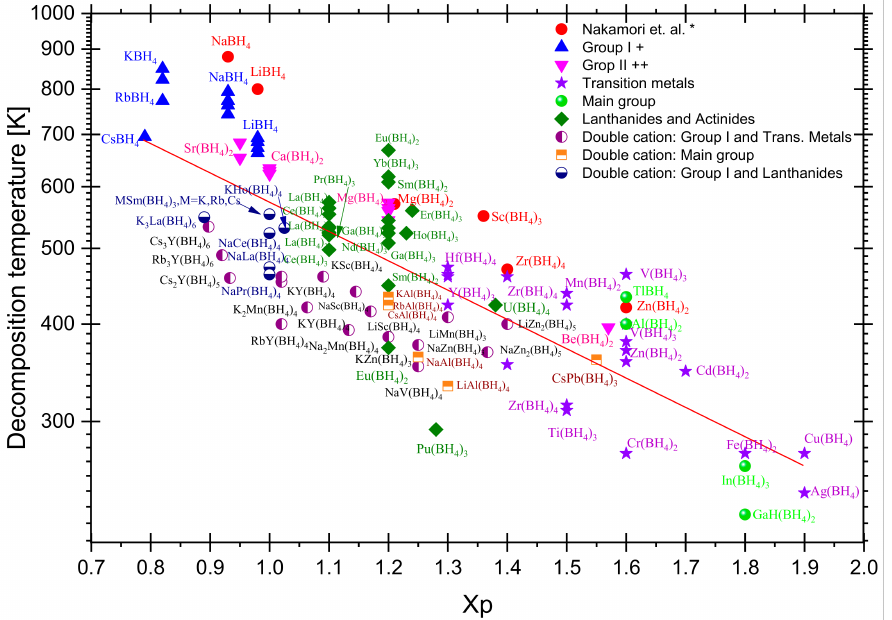
Figure 9. Compilation of dehydrogenation temperature (peak temperature whenever available, otherwise, onset temperature) versus Pauling electronegativity or weighted average Pauling elec- tronegativity. Source data: * (red dots) Nakamori et al. (2006) [30]. + Group I borohydrides: LiBH 4 [236–240], NaBH 4 [241–246], KBH 4 [4,247–249], RbBH 4 , and CsBH 4 [50]. + + Group II borohy- drides: Be(BH 4 ) 2 [250], Mg(BH 4 ) 2 [251–254], Ca(BH 4 ) 2 [255–258], and Sr(BH 4 ) 2